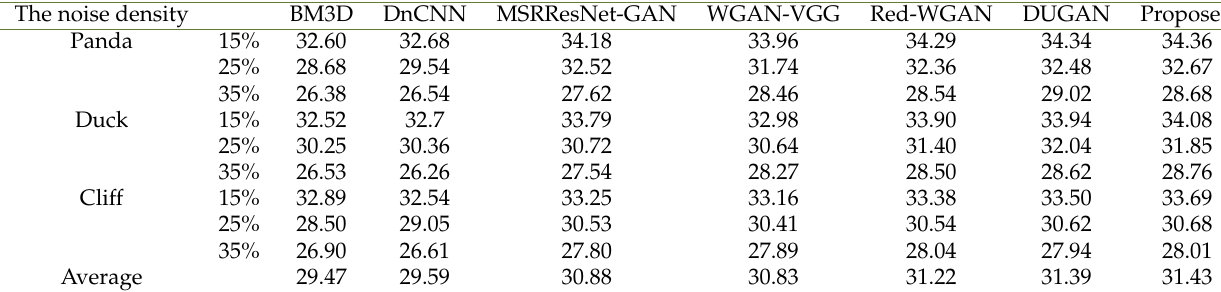
Table 1. PSNR value for figure